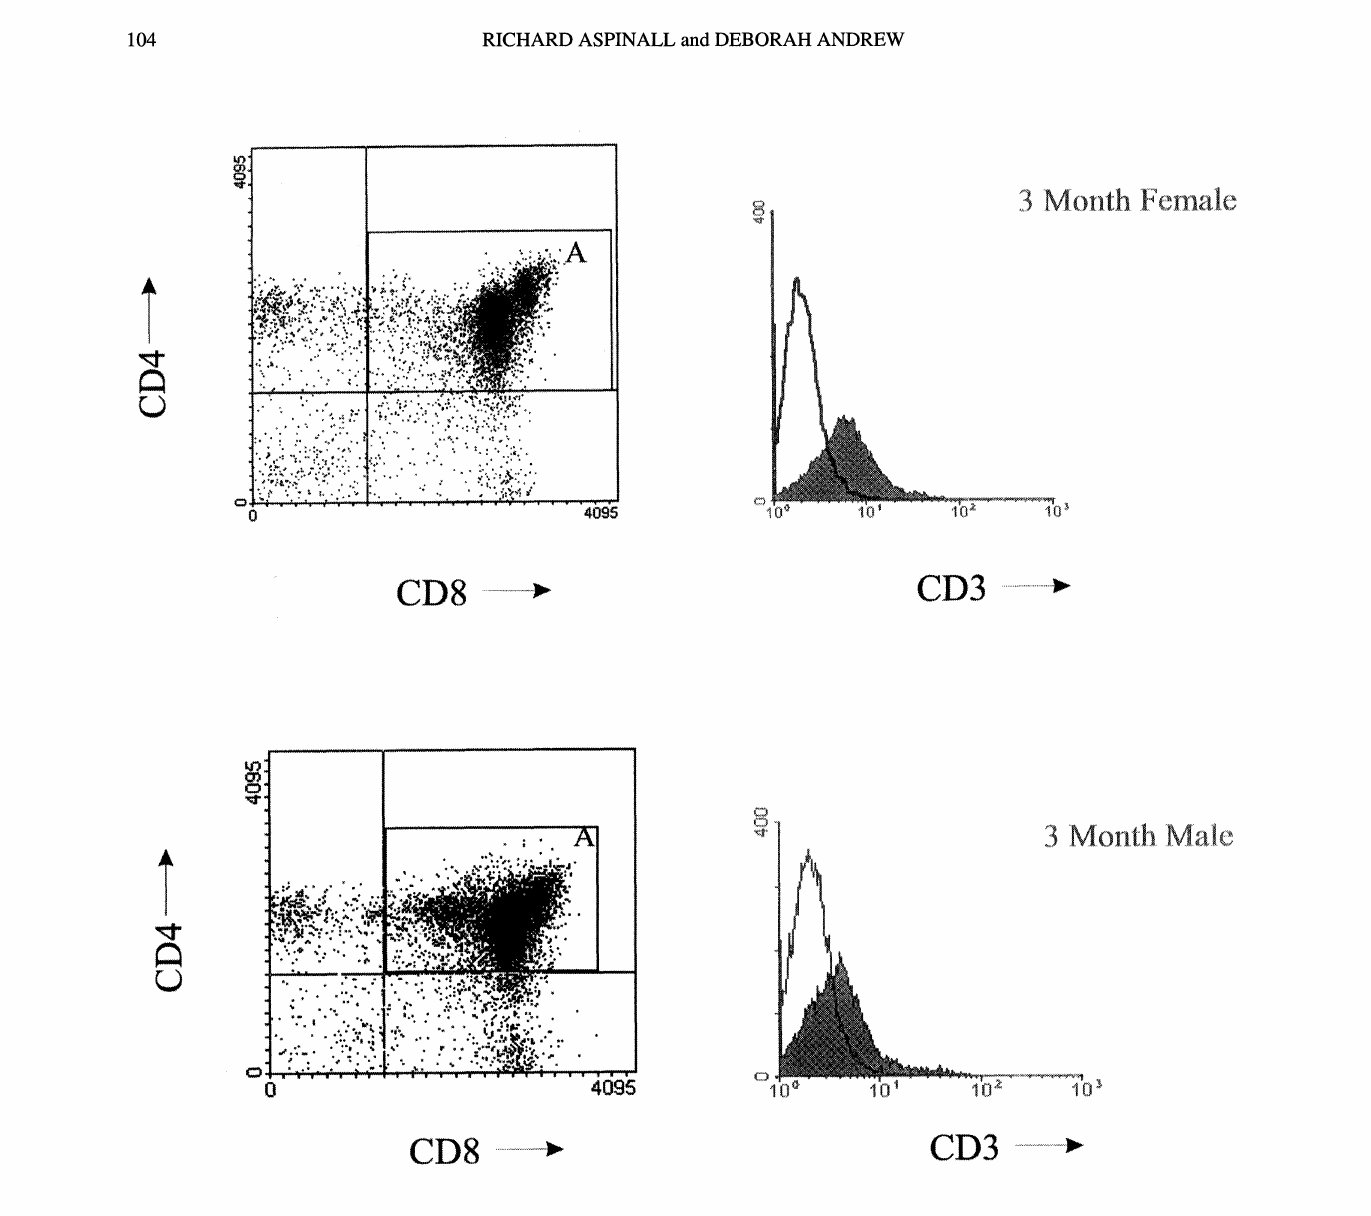
FIGURE 6 A representative experiment demonstrating similar CD3 expression on CD4+CD8 thymocytes in males and females at 3 months of